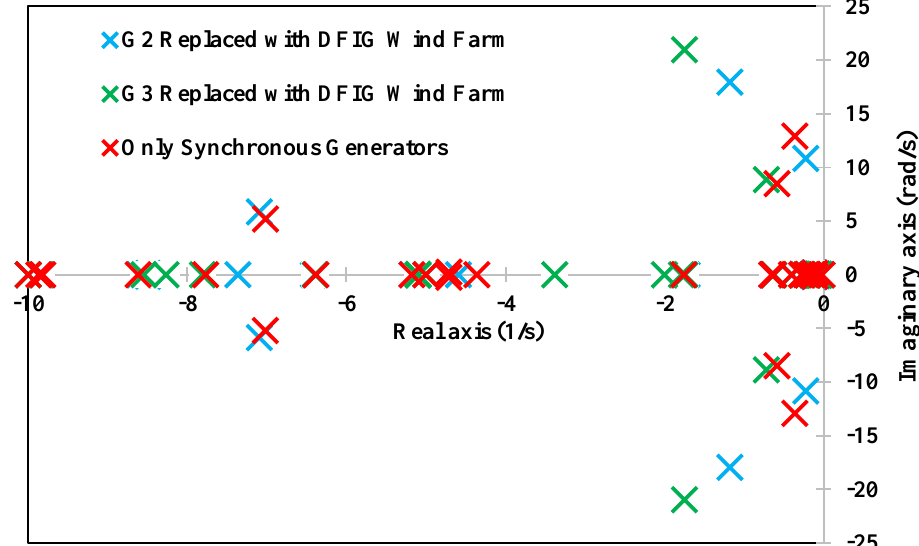
Figure 4. Eigenvalues for two wind integration scenarios and synchronous generator scenario.